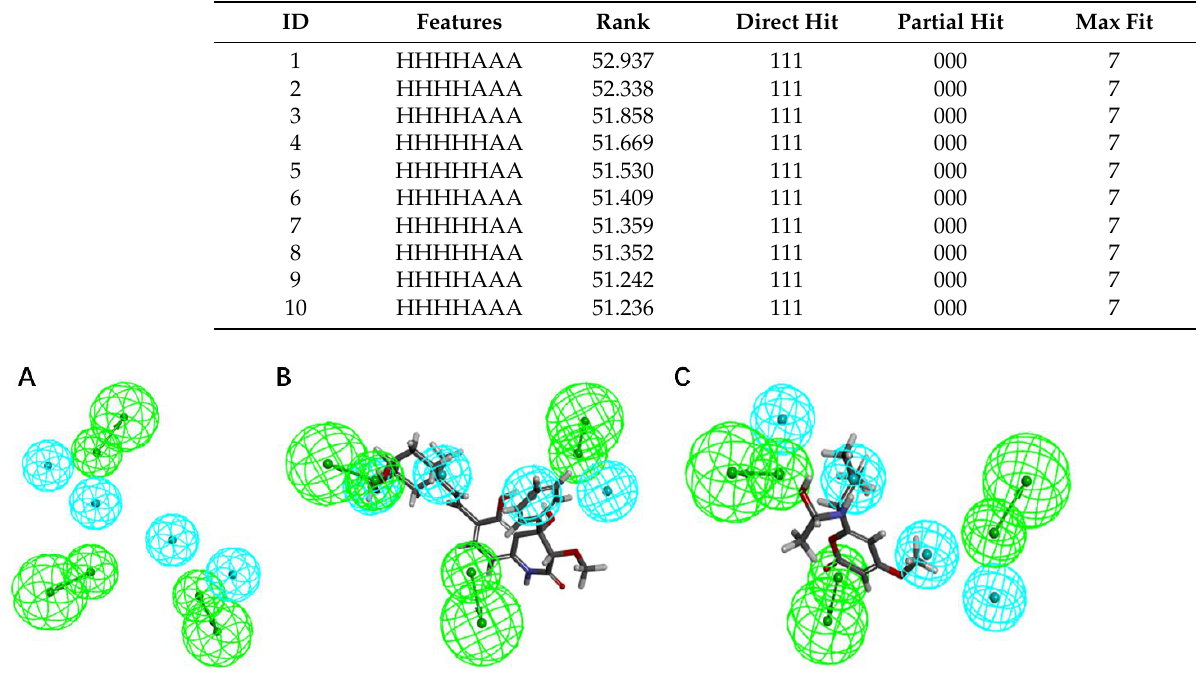
Figure 8. Toxicity alerts for compounds 44 and 31 are displayed in red font. Toxicity alerts for com- pounds 44 and 31 are displayed in red font. ( A ) Toxicity alert for compound 44 ; ( B ) toxicity alert for compound 31 . Table 5. Feature composition and ranking score of 10 pharmacophore hypothesis models generated based on common features of positive compounds.